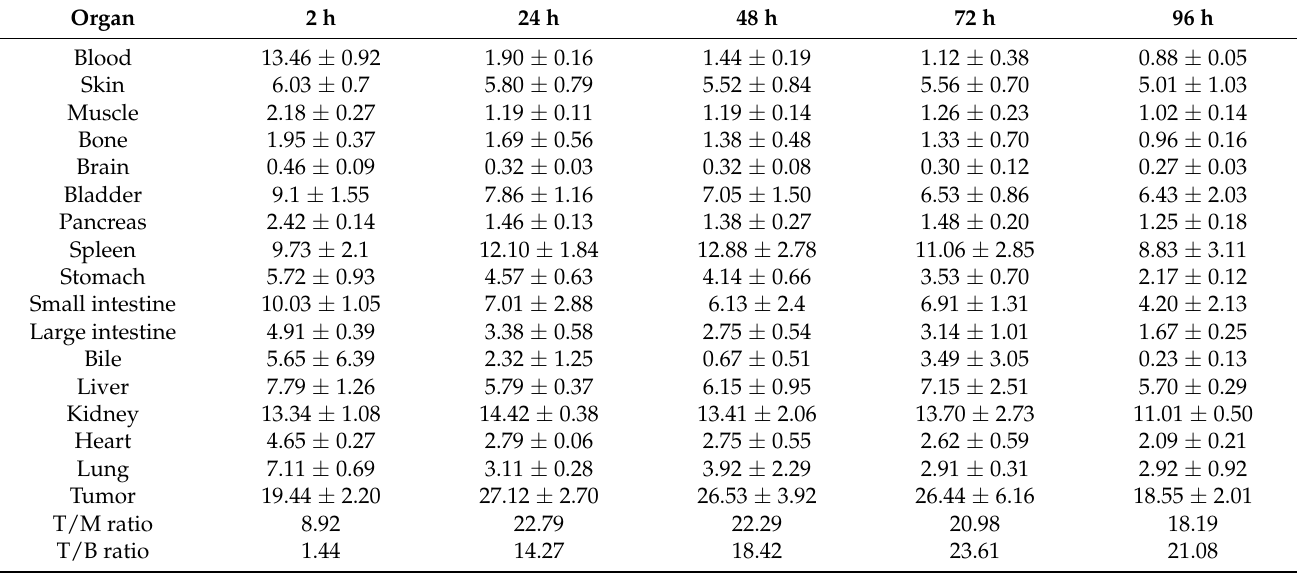
Table 2. Biodistribution of 111 In-DOTA-EB-cRGDfK after tail-vein injection in the U-87 MG tumor bearing mice.